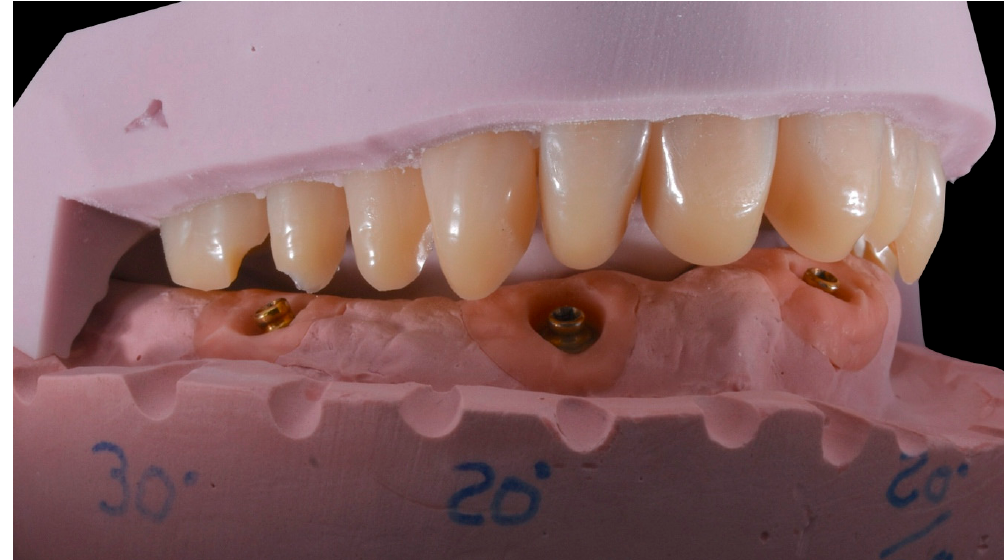
Figure 9. Silicone masks to show the prosthetic distance between the OT Equator and the teeth.